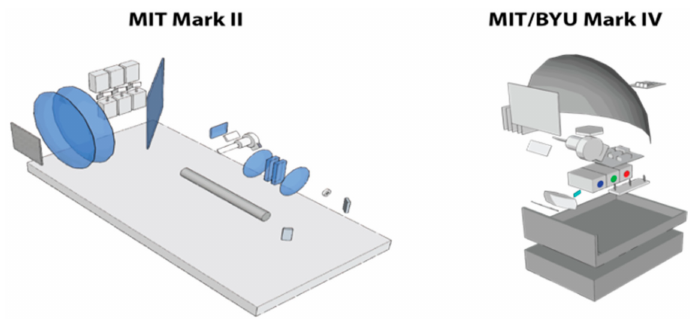
Figure 15. The Mark II ( left ) and Mark IV ( right ) scanned aperture holographic video displays